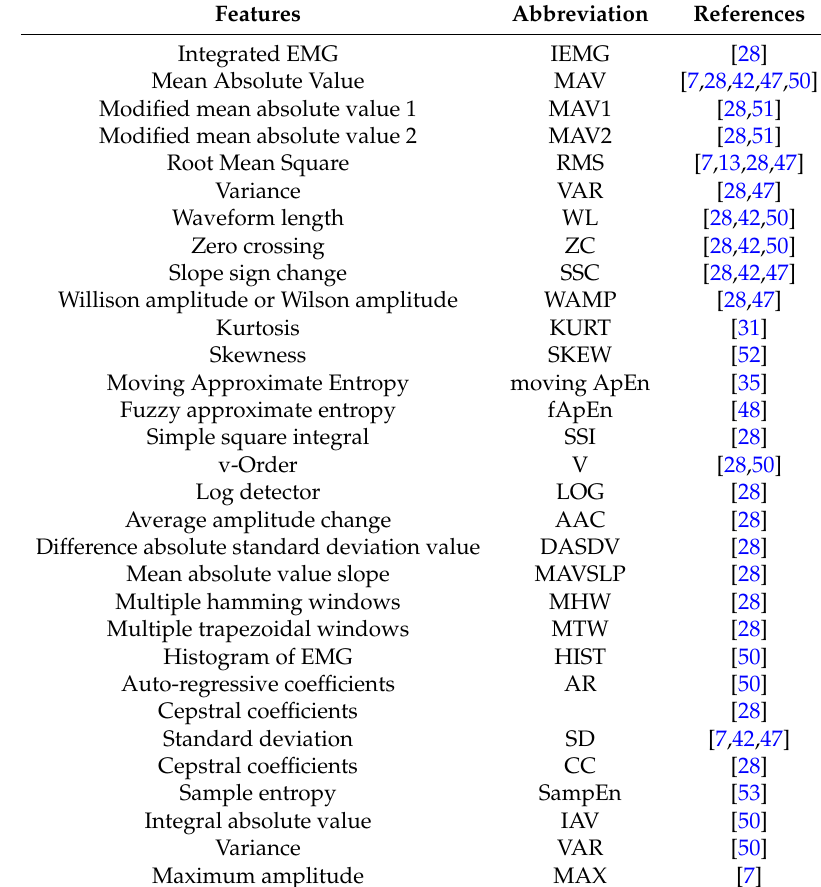
Table 1. Time domain